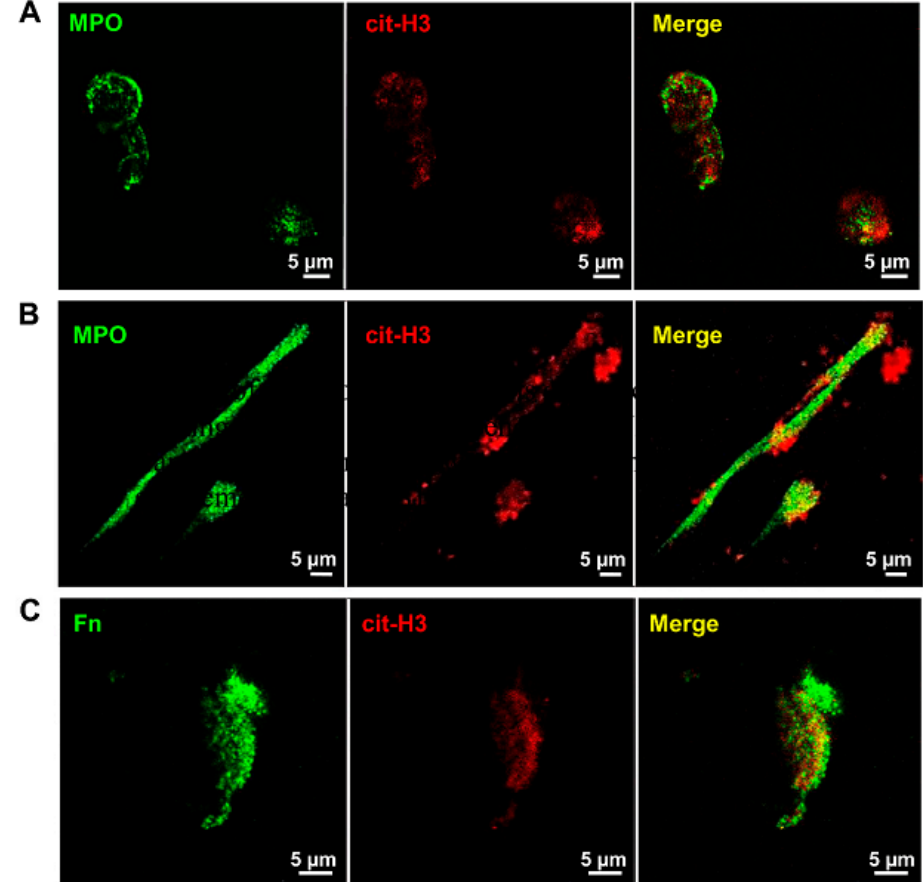
Figure 1. Characterization of selected protein components of neutrophil extracellular traps (NETs). ( A , B ) Representative images obtained by confocal microscopy showing co-localization of myeloperoxidase (MPO) (green) and citrullinated histone H3 (cit-H3) (red) in neutrophil-like cells stimulated in serum-free conditions with 25 µ M calcium ionophore for 4 h ( A ) or in isolated NETs ( B ); and ( C ) Representative images obtained with confocal microscopy showing co-localization of fibronectin (green) and cit-H3 (red) in isolated NETs. Scale bar 5 µ m. To investigate the ability of different RGD-binding integrins to mediate adhesion to NETs, a panel of human cancer cell lines with a variable expression of α 5 β 1, α v β 3, α IIb β 3 and α v β 5 integrins was subjected to adhesion assays to NETs in the presence of an excess of cyclic RGD peptide (cRGD) or cyclic control peptide (cCTRL) and compared to samples treated with DNase 1. Diluent or conditioned medium (CM) from unstimulated neutrophil-like cells were used as negative controls. The expression of each integrin chain was tested by western blotting in whole lysates of U-87 MG, HT-1080, DU 145, PC-3, H1975 and A-431 cells. Figure 2 shows representative images of western blot analysis. Levels of α 5 were faintly detected in PC-3 and A431 cells, whereas all the other cell lines expressed relatively high levels of this integrin chain. High expression of α v was found in all cell lines except A-431 cells, whereas the levels of the α IIb chain were higher in U-87 MG, HT-1080 and H1975 cells than in DU 145, PC-3 and A-431 cells. Among all β chains analyzed, A-431 cells lacked the β 1 chain, whereas PC-3 cells showed only a faint signal for the same protein. Finally, β 5 expression was faintly detected in U-87 MG cells, whereas β 3 was found in all cell lines. Results of the densitometric analysis of western blotting signal are reported in Figure